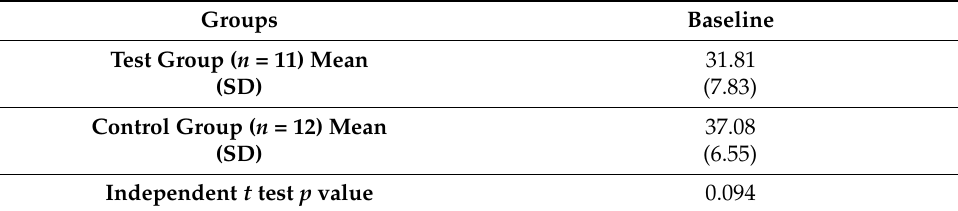
Scheme 3. Intergroup comparison of marginal bone loss. Table 6. Intergroup comparison of mean primary stability in test and control